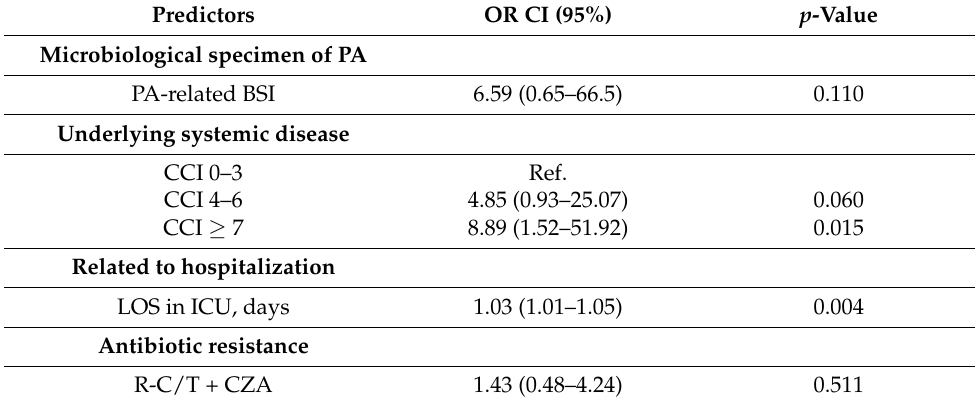
Figure 2. Survival curve showing overall (left panel) and attributable 30-day mortality (right panel) in patients colo- nized/infected with S-CZA-C/T vs. R-CZA-C/T-R PA. Table 3. Multivariable model of risk factors for 30-day attributable mortality.